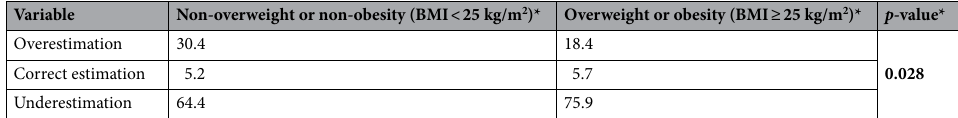
Table 3. Accuracy of estimating body weight relative to overweight or obesity status. *Overweight or obesity classification was based on the extended International Obesity Task Force (IOTF) age- and sex-specific BMI cutoff reference standards, which is equivalent to adults’ BMI at above or below 25 kg/m 2 (Ref. 26 ). Significant values are in bold.